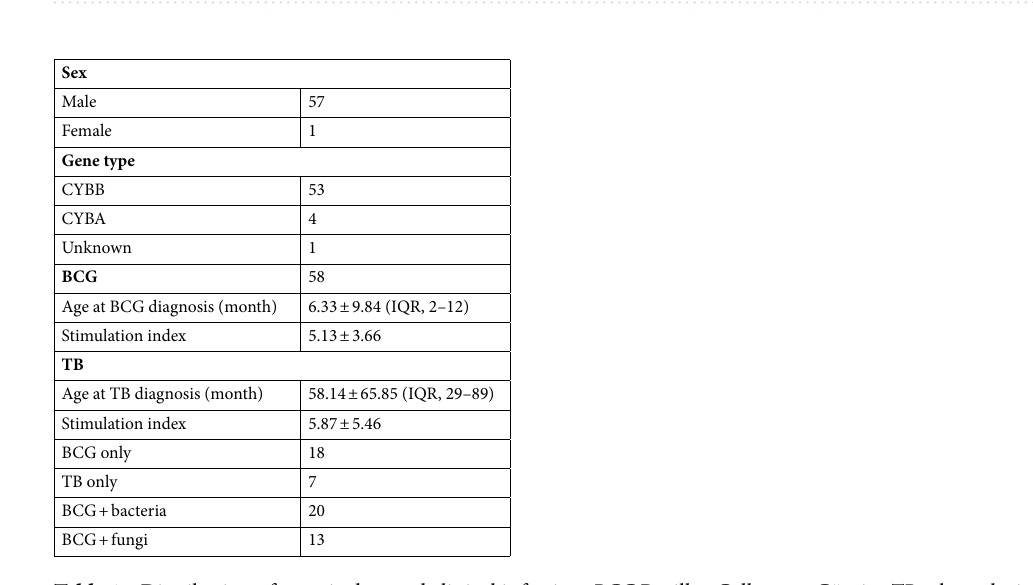
Figure 1. Study flowchart. CGD chronic granulomatous disease, BCG Bacillus Callmette–Güerin, TB tuberculosis.